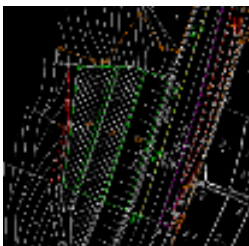
Figure 4. Top view of completed roads